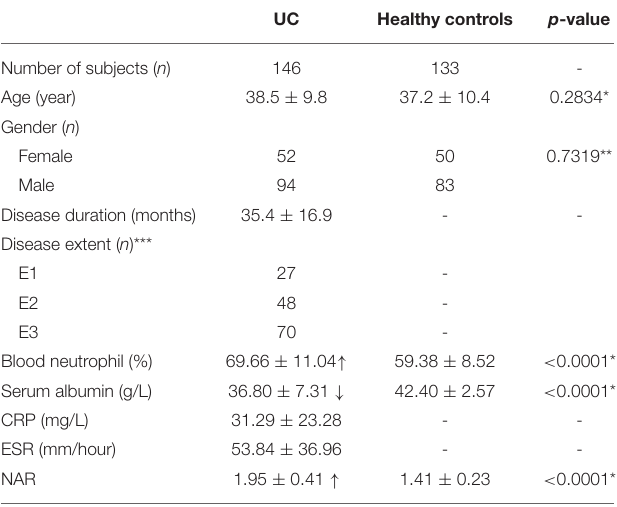
TABLE 1 | Demographics and clinical parameters of patients with UC and healthy controls. UC Healthy controls